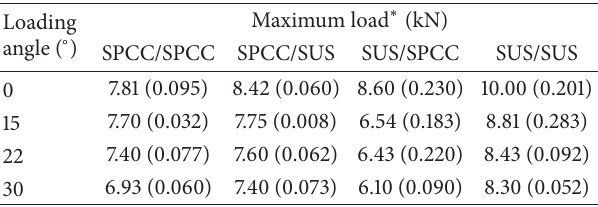
Table 3: The quasi-static failure loads of the FSSW joints under various loading